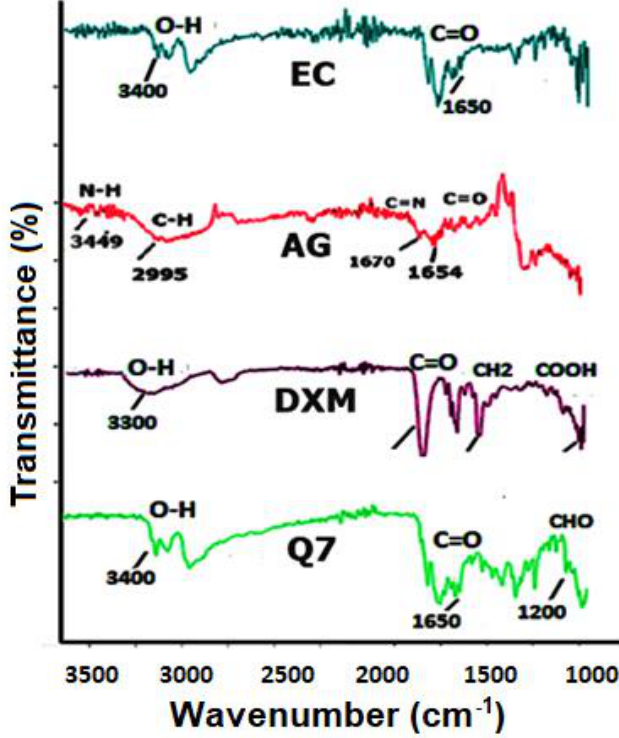
Figure 1. FTIR spectra of DXM, the polymer and the physical mixtures .